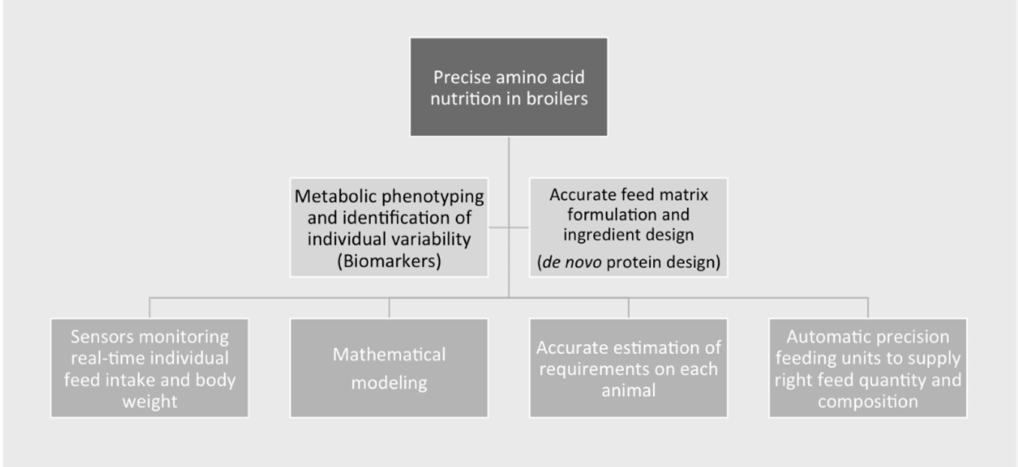
Figure 5. Integrated framework scheme for precise amino acid nutrition in broiler farming, combining nutritional strategies and feeding